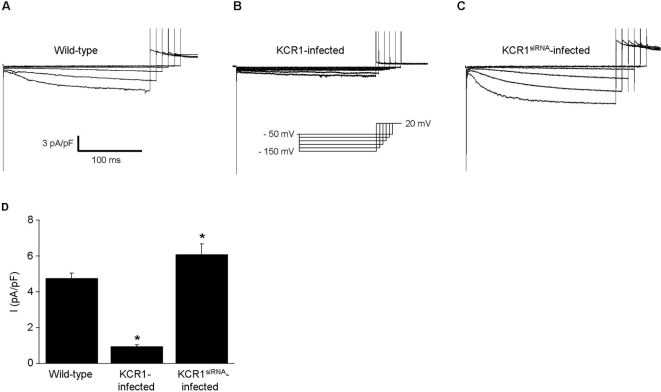
KCR1 reduces current size of native If in neonatal rat cardiomyocytes.(A–C) Original whole-cell recordings of If in neonatal rat cardiocytes: (A) control, (B) KCR1-infected and (C) KCR1siRNA-infected. (D) Mean current densities of If in neonatal cells show that KCR1 overexpression reduced If, while suppression of endogenous KCR1 by KCR1siRNA significantly increased native If (*, p<0.001). For data see text.